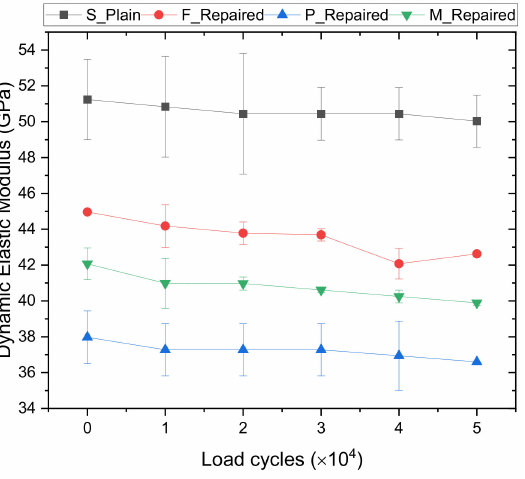
Figure 12. Change in dynamic elastic modulus as a result of flexural cyclic